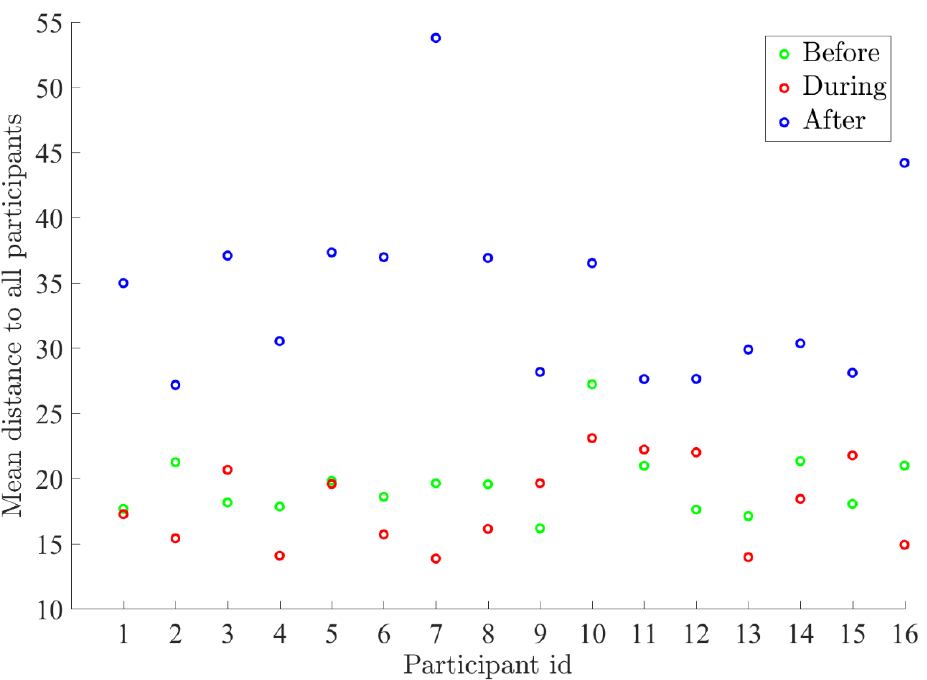
Figure A10. Pairwise synchronization for Lithuania’s group. For the majority of participants (11 out of 16) the mean Euclidean distance during the HLI was smaller than before the HLI, indicating that those participants were more coherent with the group during the HLI than they were before it. The mean distance after the HLI is larger (for all participants) than before the HLI. Three participants who were outliers and extremely far away from others during the HLI were removed from the